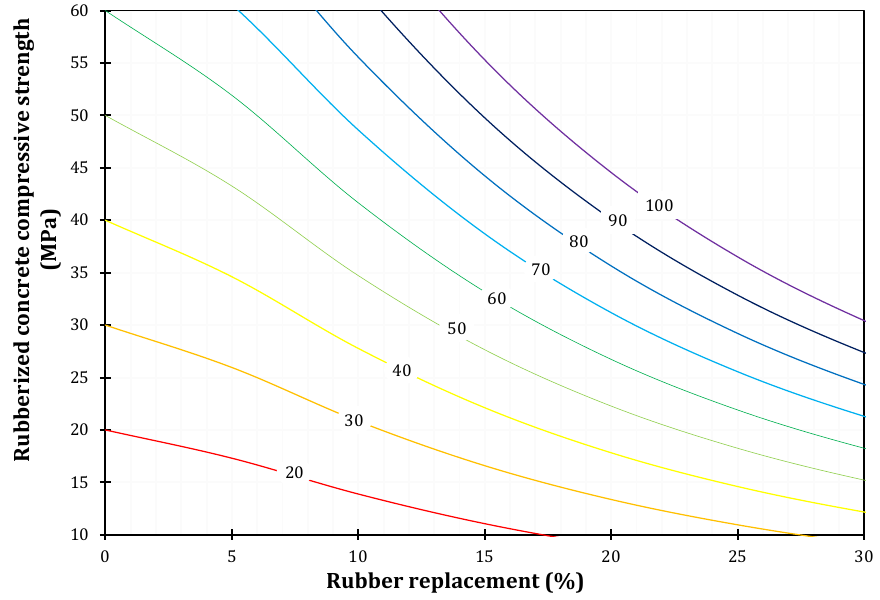
Figure 15. Model for rubberized concrete compressive strength.